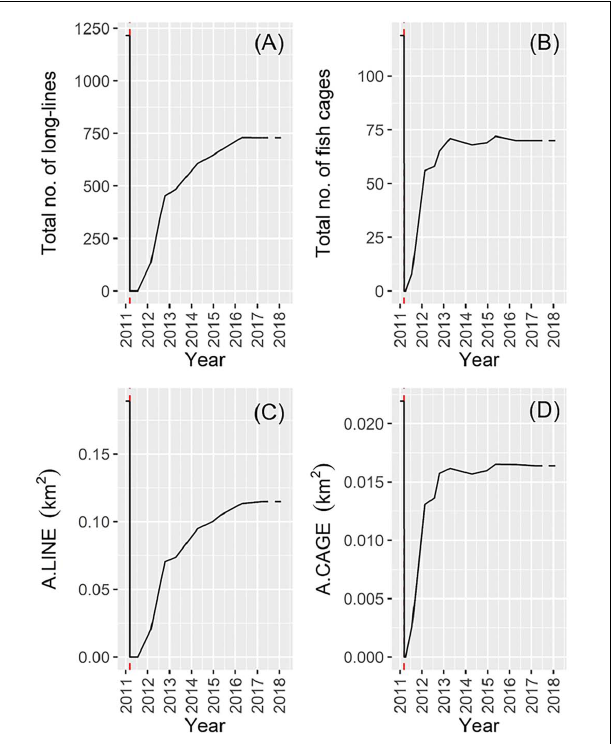
FIGURE 8 | Change in the total number of: (A) long-lines; (B) fish cages, and changes in the total area of: (C) long-lines; (D) fish cages (the red dotted line denotes the date of the 2011 disaster). Satellite data for January 2018 were not available and the corresponding values were therefore assumed identical to those estimated in March